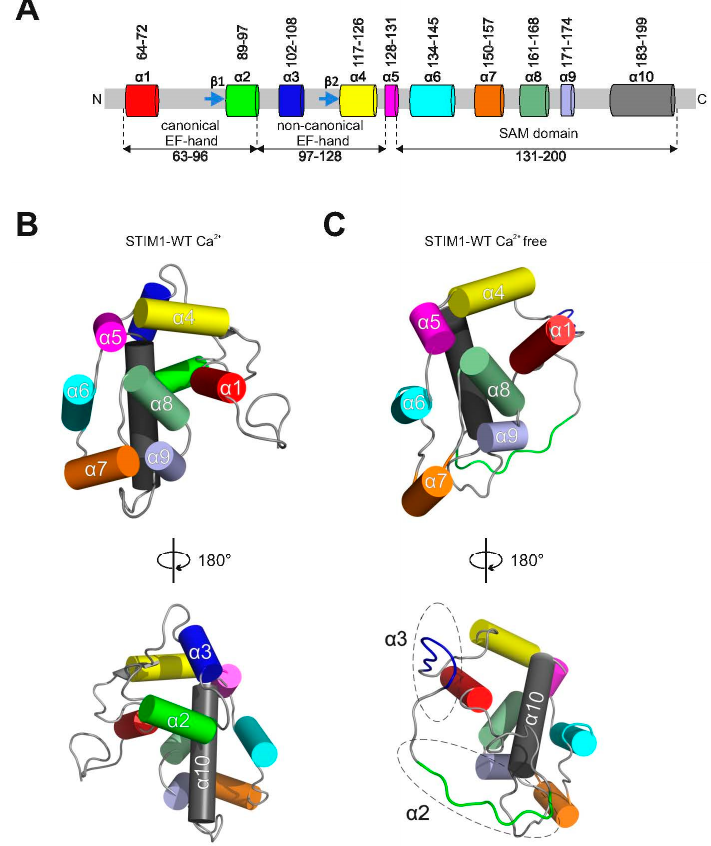
Figure 1. Conformational rearrangement of luminal STIM1 upon Ca 2 + depletion. ( A ) Schematic representation of the secondary structure of the canonical, non-canonical, and sterile alpha motif (SAM) domains in luminal STIM1 proteins ( α -helices are shown as cylinders and β -sheets as arrows). ( B ) Two orientations are shown for the Ca 2 + -bound resting state of STIM1 based on NMR results [11]. The helices (shown as cylinders) are labeled as follows: canonical EF-hand: helices 1 (red) and 2 (green); non-canonical EF-hand: helices 3 (blue) and 4 (yellow); a short connecting helix 5 (purple); and the SAM domain: helices 6 to 10 (turquoise, brown, dark green, light blue, gray). ( C ) Luminal STIM1 structure (from MD simulations) upon Ca 2 + depletion compared with ( B ) in terms of helix structures. Helices 2 and 3, indicated by dashed circles, are unfolded in MD